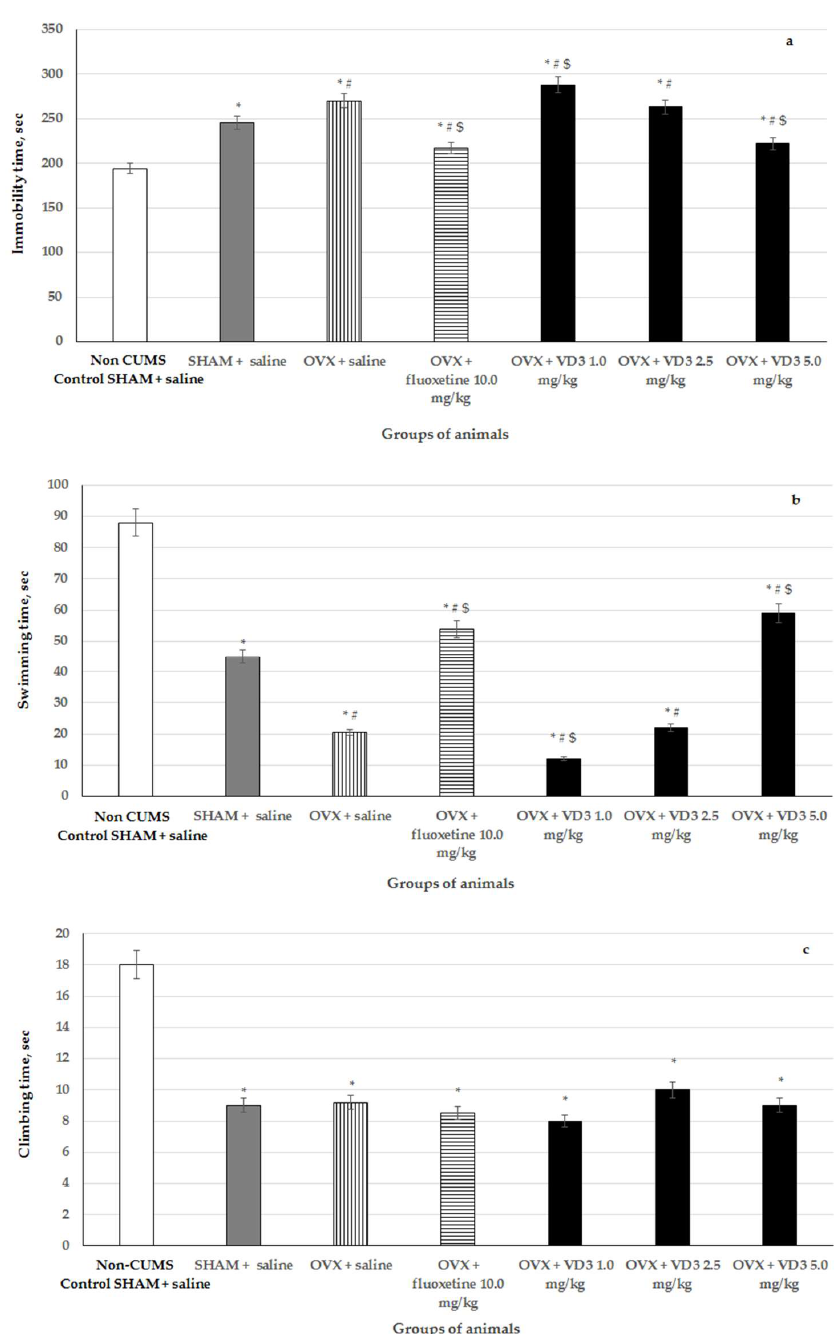
Figure 4. Effects of VD 3 administered in various doses on depression-like behavior in long-term OVX rats subjected to CUMS in the forced swimming test. ( a )—immobility time, sec, ( b) —swimming time, sec, ( c )—climbing time, sec. *— p < 0.05 versus the non-CUMS SHAM group (control group) treated with saline, #— p < 0.05 versus the SHAM group with CUMS treated with saline, $— p < 0.05 versus the long-term OVX group with CUMS treated with saline. The data are presented as the mean ± SD; n = 7 in each